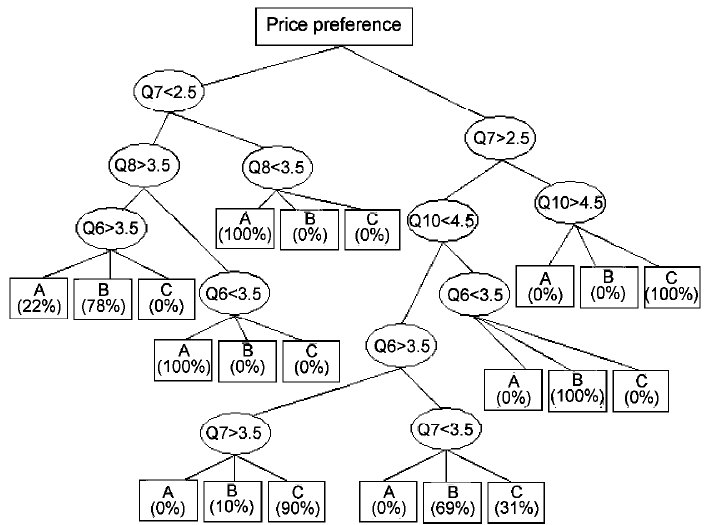
Fig. 3. A Decision Tree with “price preference” as objective